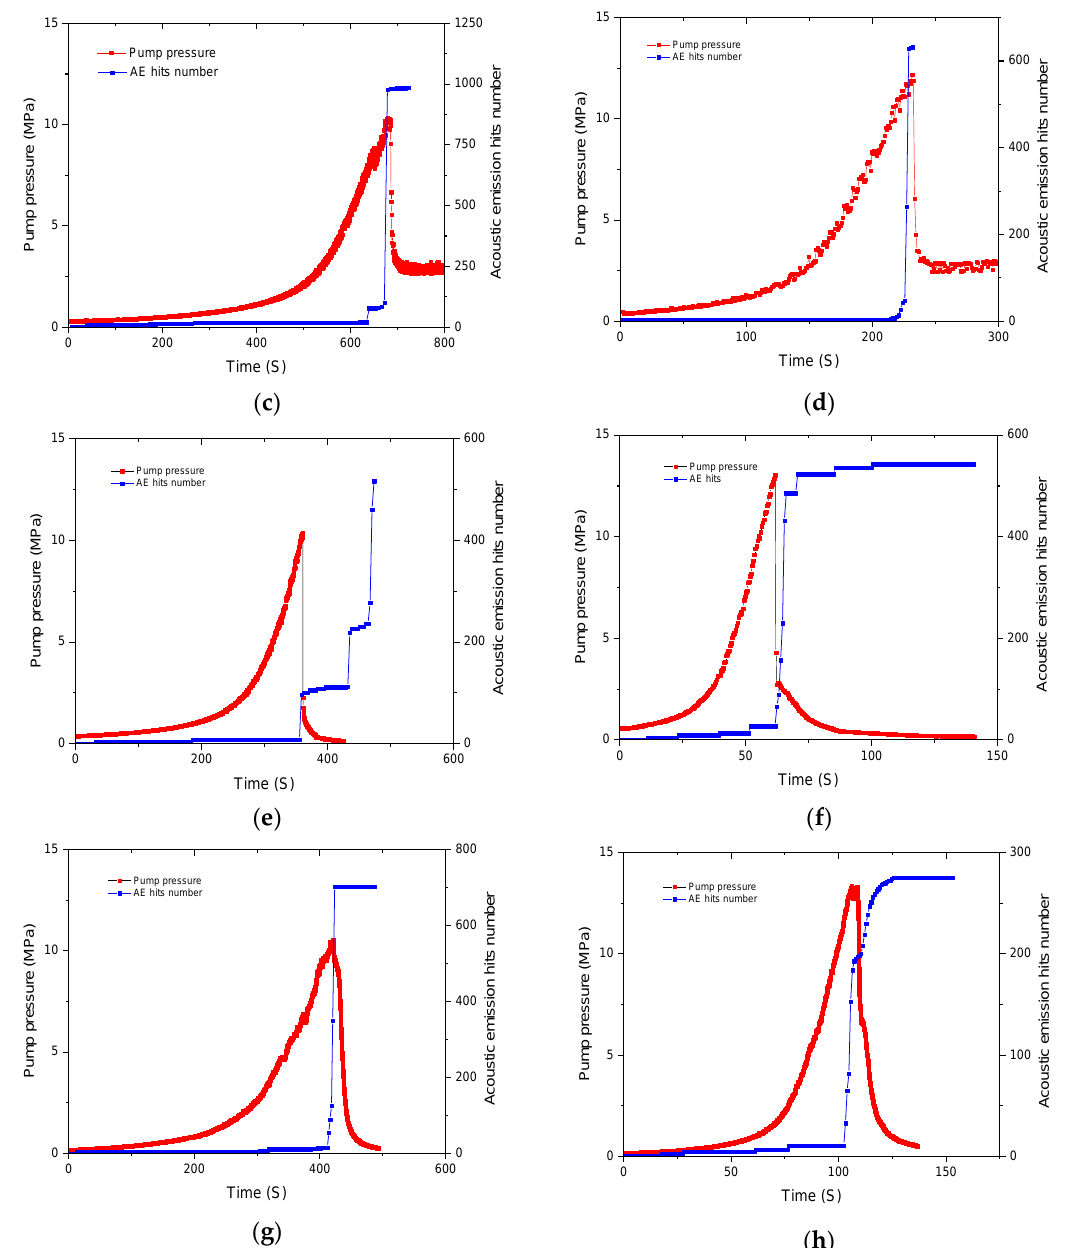
Figure 3. Relationship between fracturing pressure and AE characteristics with different fracturing fluids and pump flow rate: ( a ) C-2-7 slick water (0.02 mL/s); ( b ) C-2-8 slick water (0.07 mL/s); ( c ) C-2-3 guar gum (0.02 mL/s); ( d ) C-2-4 guar gum (0.07 mL/s); ( e ) C-1-1 cross-linked acid (0.02 mL/s); ( f ) C-1-2 cross-linked acid (0.07 mL/s); ( g ) C-1-7 gelled acid (0.02 mL/s); ( h ) C-1-8 gelled acid (0.07 mL/s).